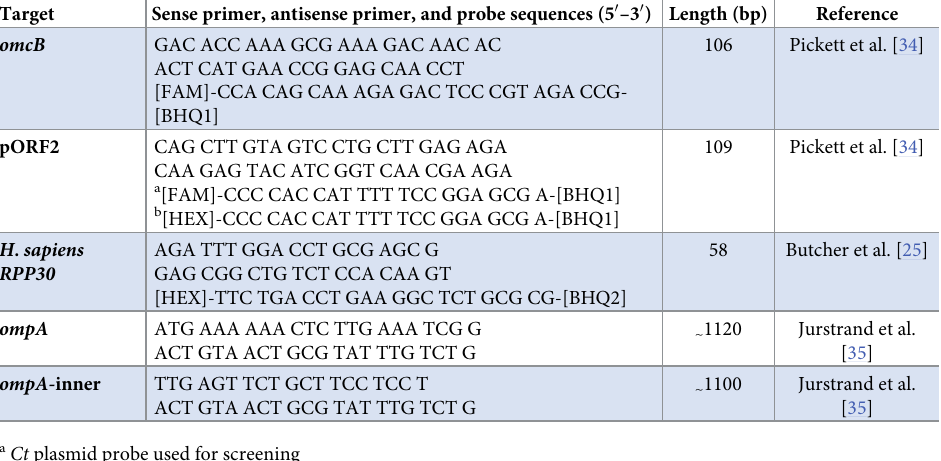
Table 1. Primers and probes used for PCR